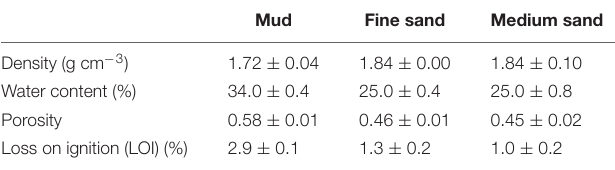
TABLE 1 | Mean density, water content, loss on ignition and porosity values for mud, fine sand, and medium sand. Mud Fine